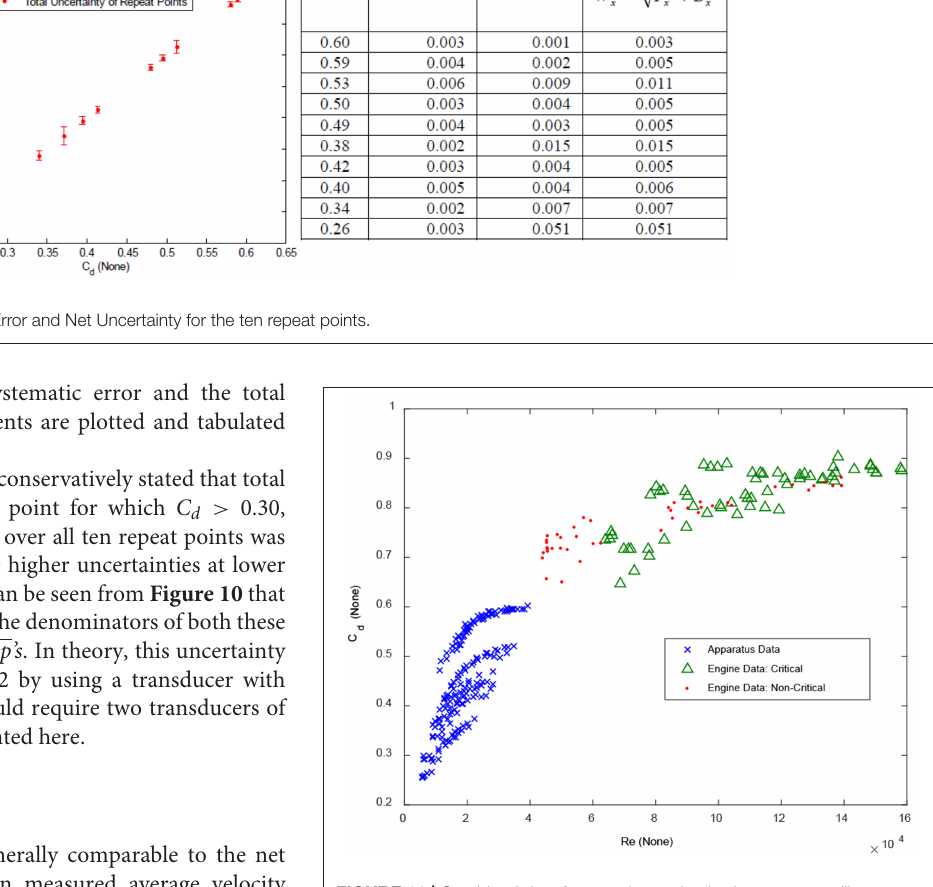
FIGURE 11 | Combined data from engine and pulsating apparatus illustrate the greater range of C d relative to non-pulsating